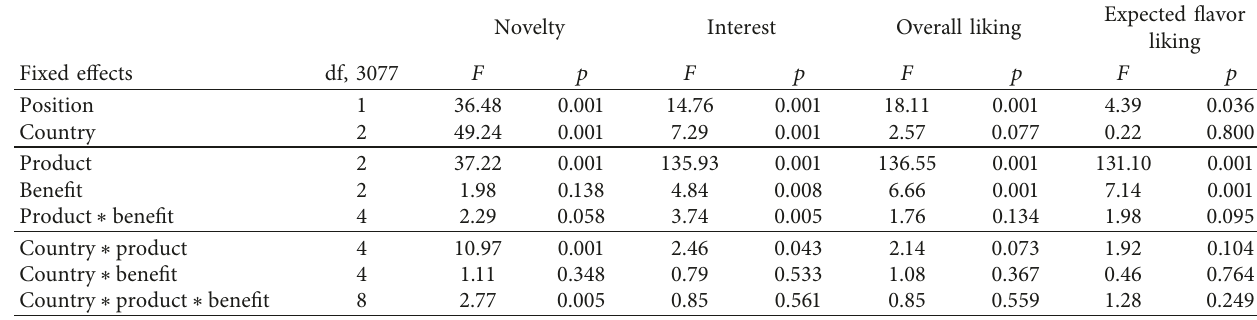
Table 5: Experimental factors product, benefit, country, and their interaction as moderators for the dependent variables novelty, interest, overall liking, and expected flavor liking (M3).